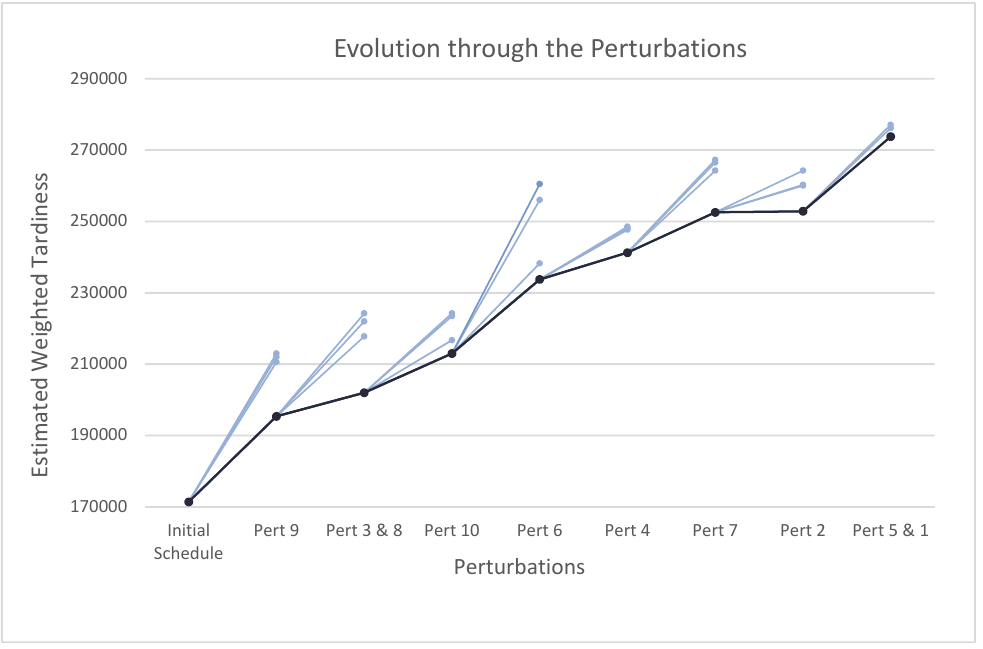
Fig. 3. Manufacturing execution monitoring degradation and choosing best AGA control